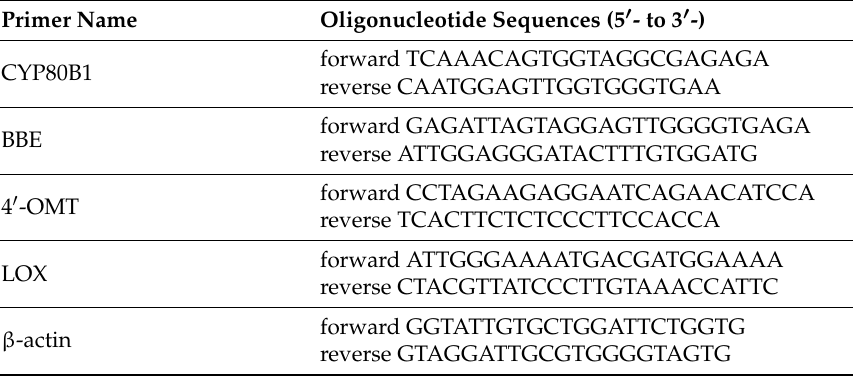
Table 1. Nucleotide sequences of